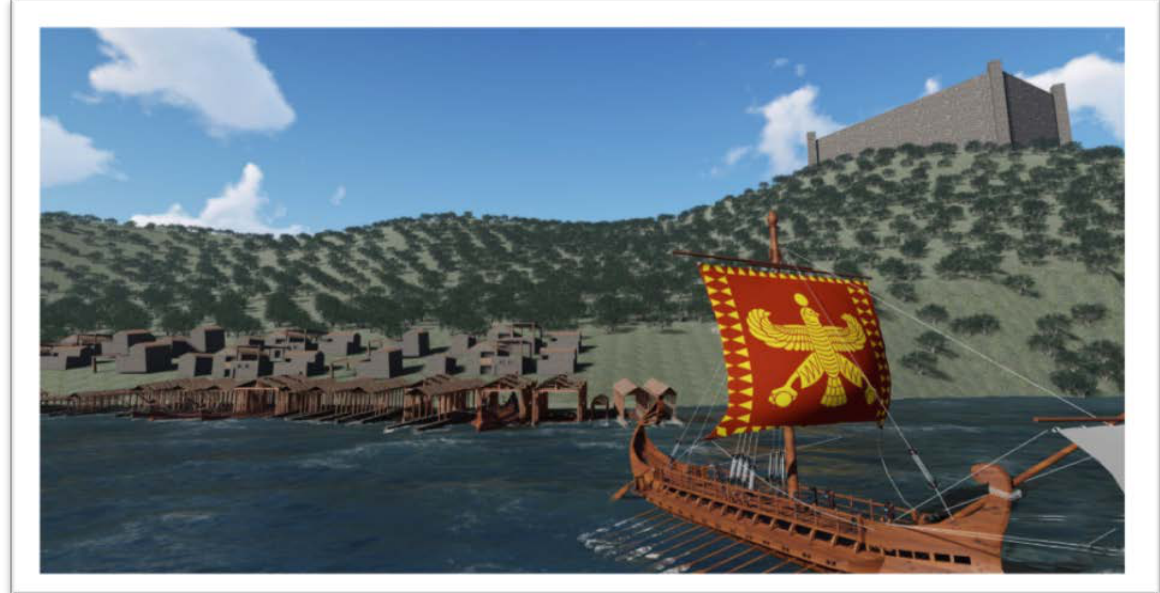
Figure 14 Persian warships during Lade Island naval